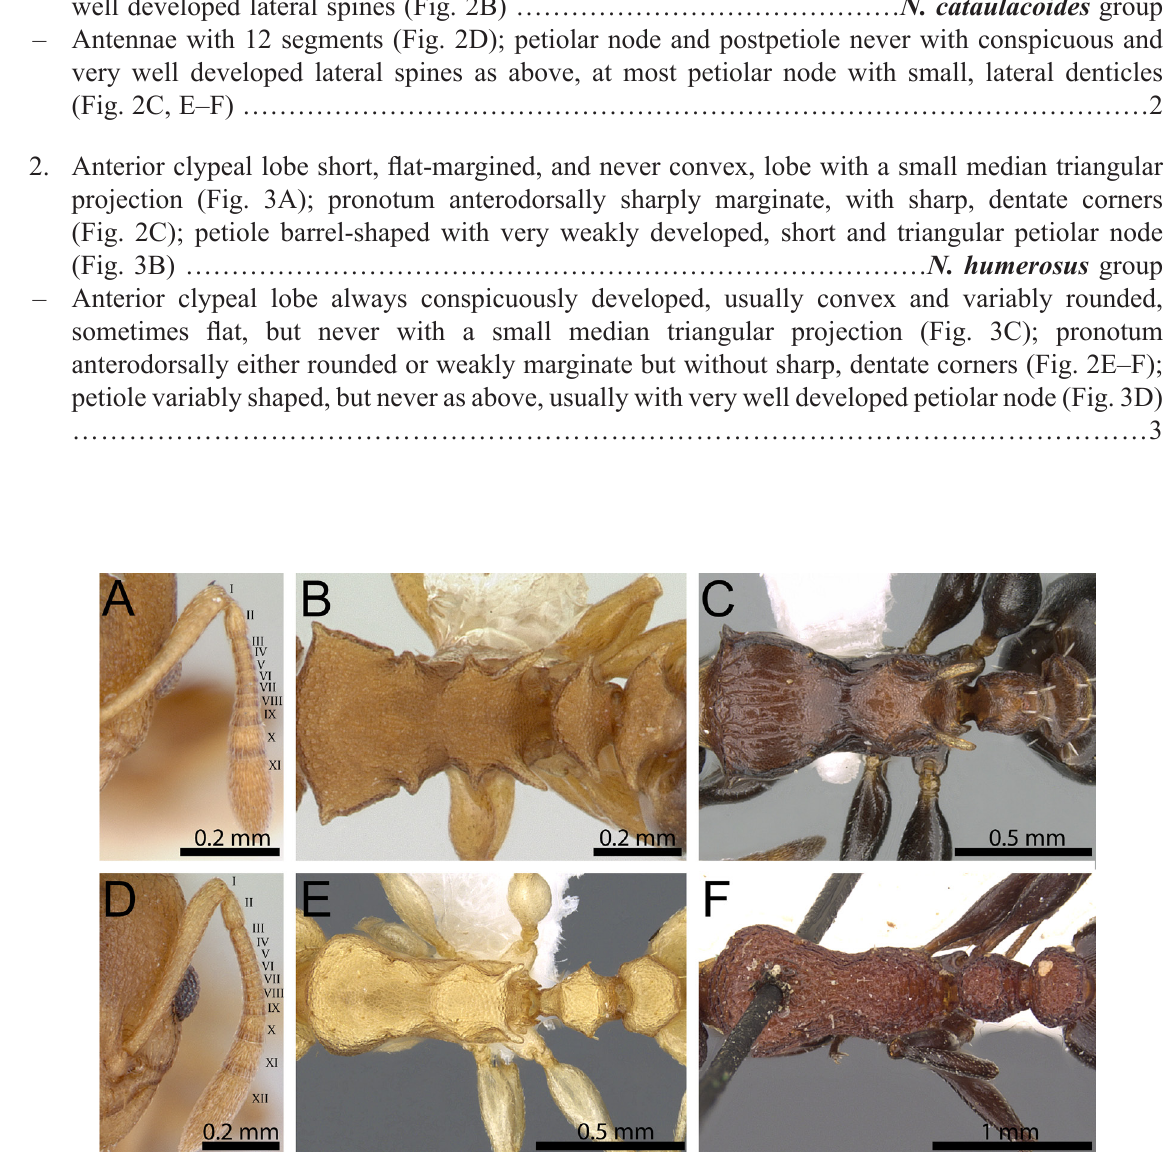
Fig. 2. Part of head in full-face view showing the antennae (antennal segments are counted in Roman numerals) and dorsum of mesosoma. A–B . Nesomyrmex cataulacoides (Snelling, 1992) (CASENT0172593, CASENT0178301). C . N. humerosus (Emery, 1896) (CASENT0906196). D . N. evelynae (Forel, 1916) (CASENT0178298). E . N. stramineus (Arnold, 1948) (CASENT0922011). F . N. braunsi (Forel, 1912)